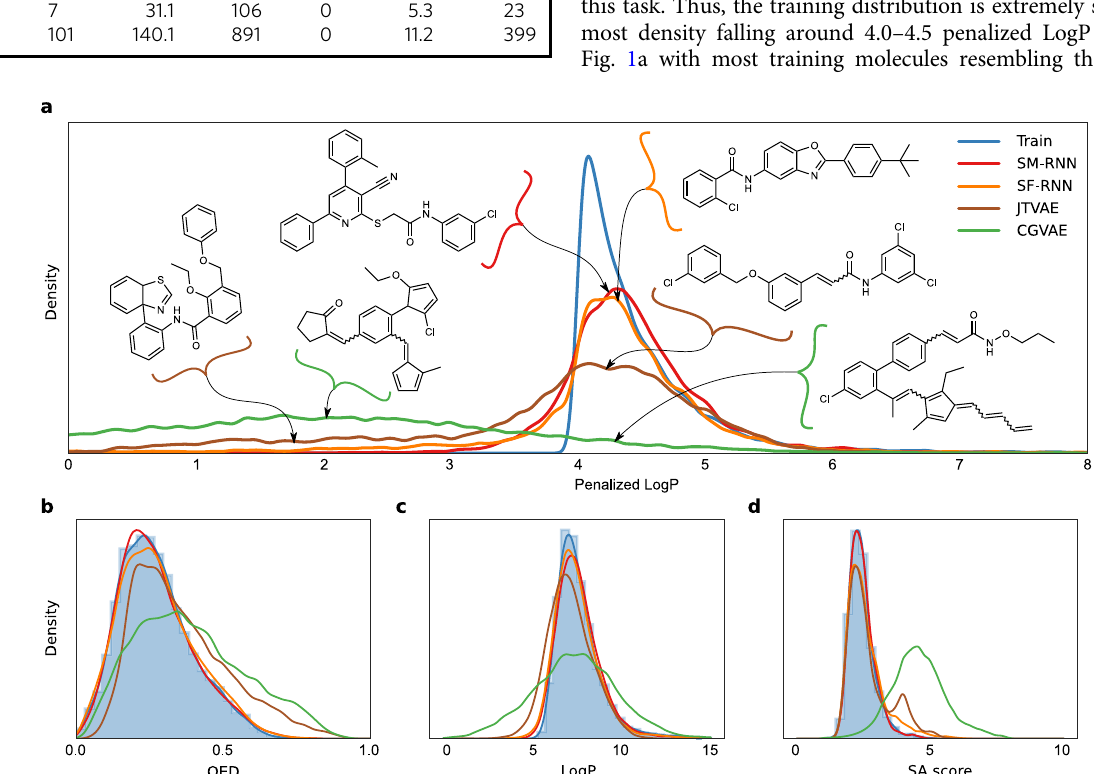
Fig. 2 Penalized LogP Task I. a The plotted distribution of the penalized LogP scores of molecules from the training data (TRAIN) with the SM-RNN trained on SMILES, the SF-RNN trained on SELFIES and graph models: CGVAE and JTVAE. For the graph models we display molecules from the out of distribution mode at penalized LogP score 2 ½ 1 : 75 ; 2 : 25 (cid:2) as well as molecules with penalized LogP score in the the main mode [4.0,4.5] from all models. b – d Distribution plots for all models and training data of molecular properties QED, LogP, and SA